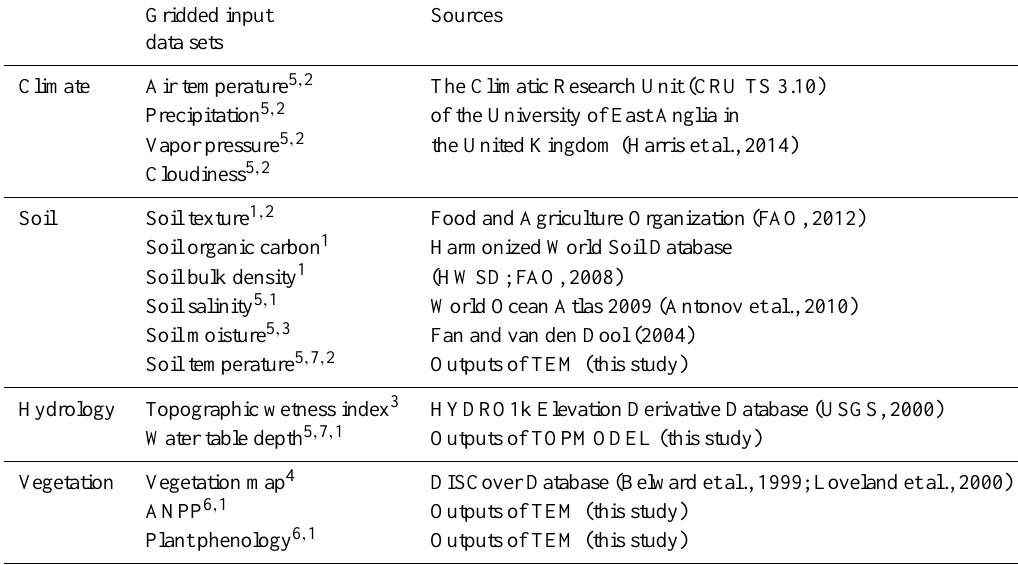
Table 1. Summary of the gridded input data sets for driving the model